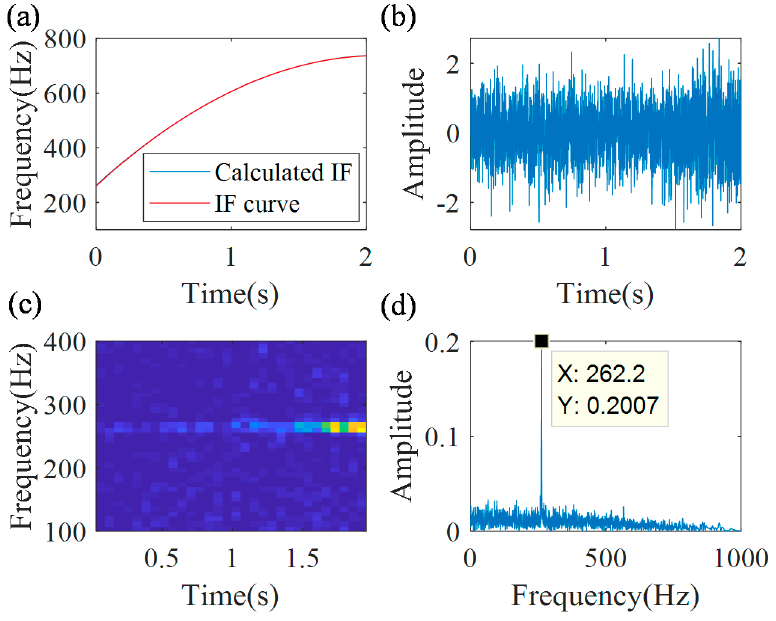
Figure 7. MGDT results: ( a ) calculated IF curve; ( b ) demodulated signal; ( c ) TFR; and ( d ) the spectrum.